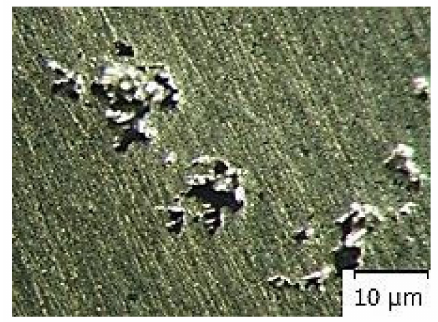
Figure 10. Microscopic evaluation of sample 4/ × 100/.